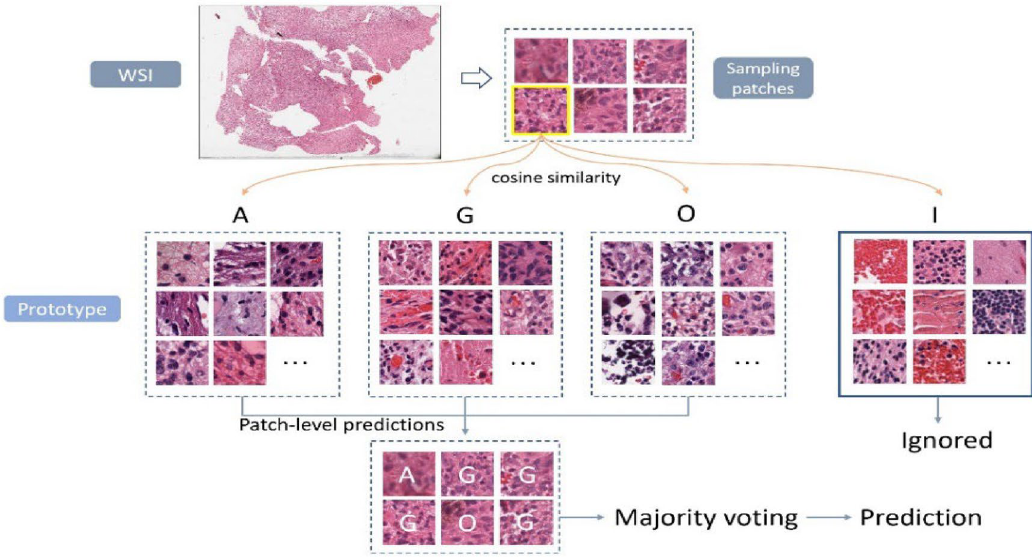
Figure 5. Example of case-level inference in the proposed WSI-approach.